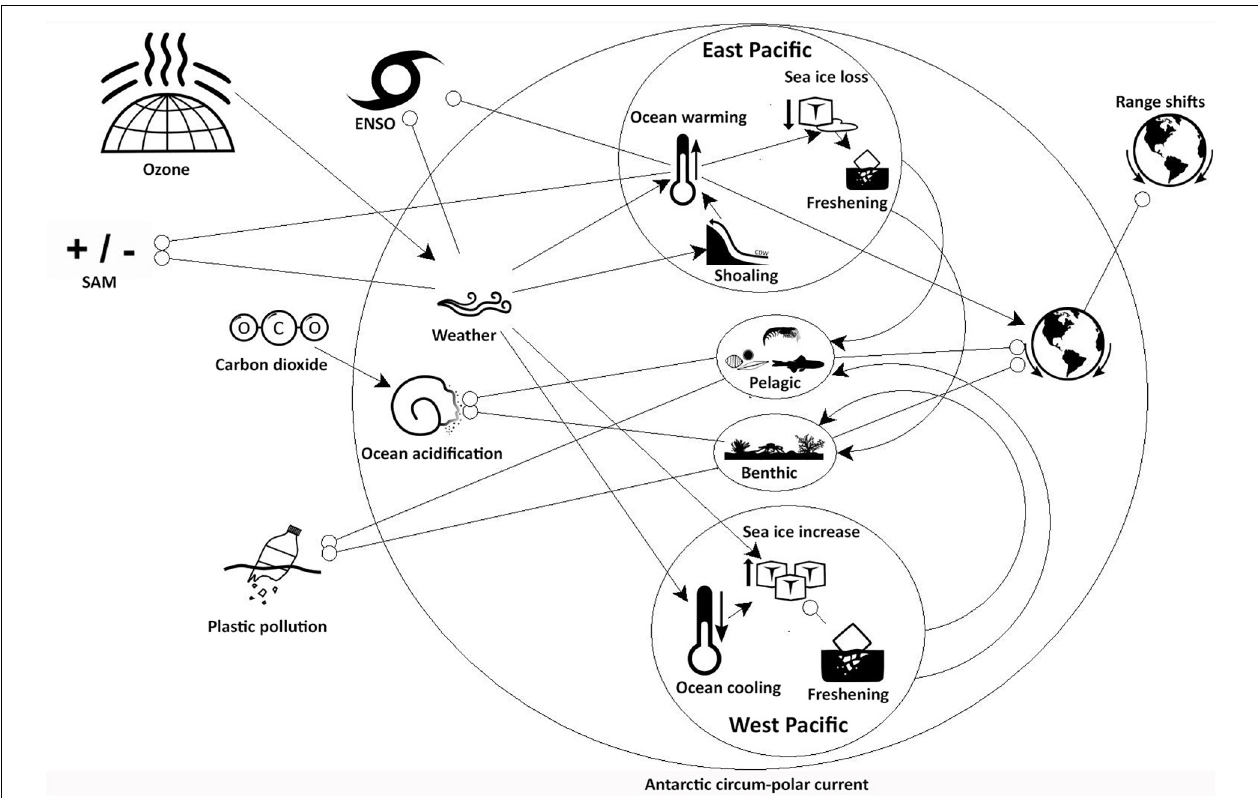
FIGURE 4 | Qualitative network diagram describing the linkages between the global drivers and the benthic and pelagic Southern Ocean assemblages. Northern drivers are global drivers whose influence comes from North of the Antarctic cirucm-polar current (ACC). Contrasting effects are highlighted by separate west Pacific (western Antarctic Peninsula) and east Pacific regional networks. Range shifts from north of the ACC (Non-indigenous species) and within the Southern Ocean are indicated separately. An arrow head indicates a positive influence, an open circle indicates a negative influence.